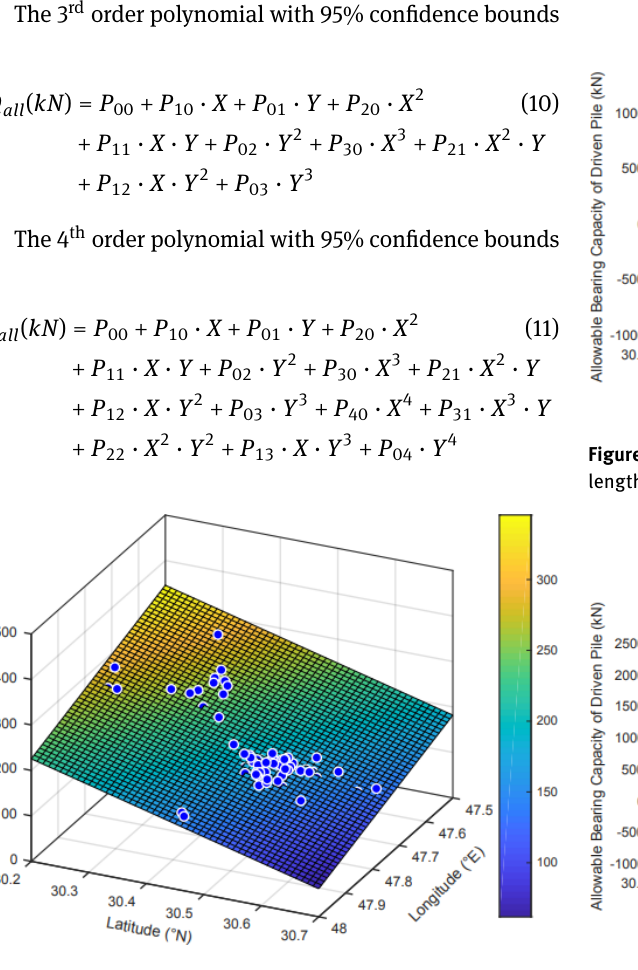
Figure 3: Variation of the allowable bearing capacity of driven piles (6 m length) using 1 st order polynomial